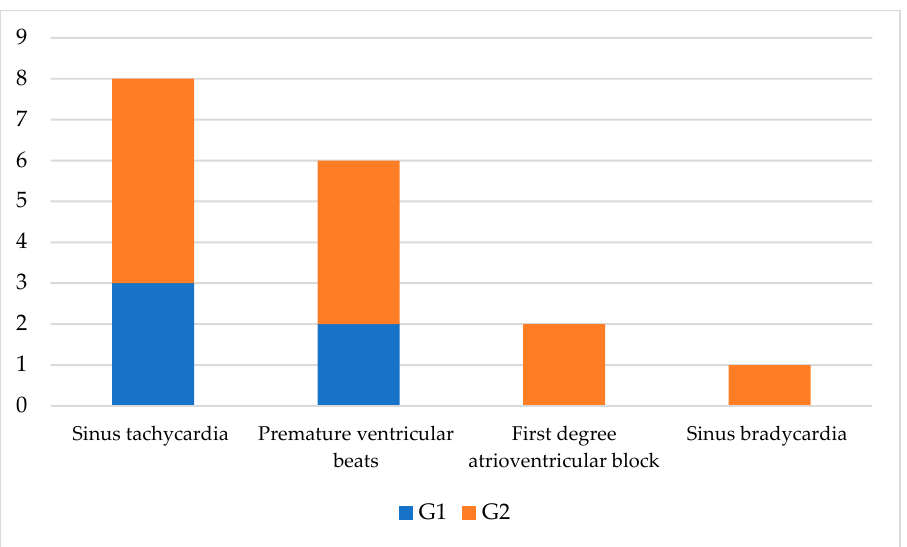
Figure 1 . Graphical representation of arrhythmias detected in ECGs of SIRS affected dogs with a favorable (G1) and poor (G2) prognosis.